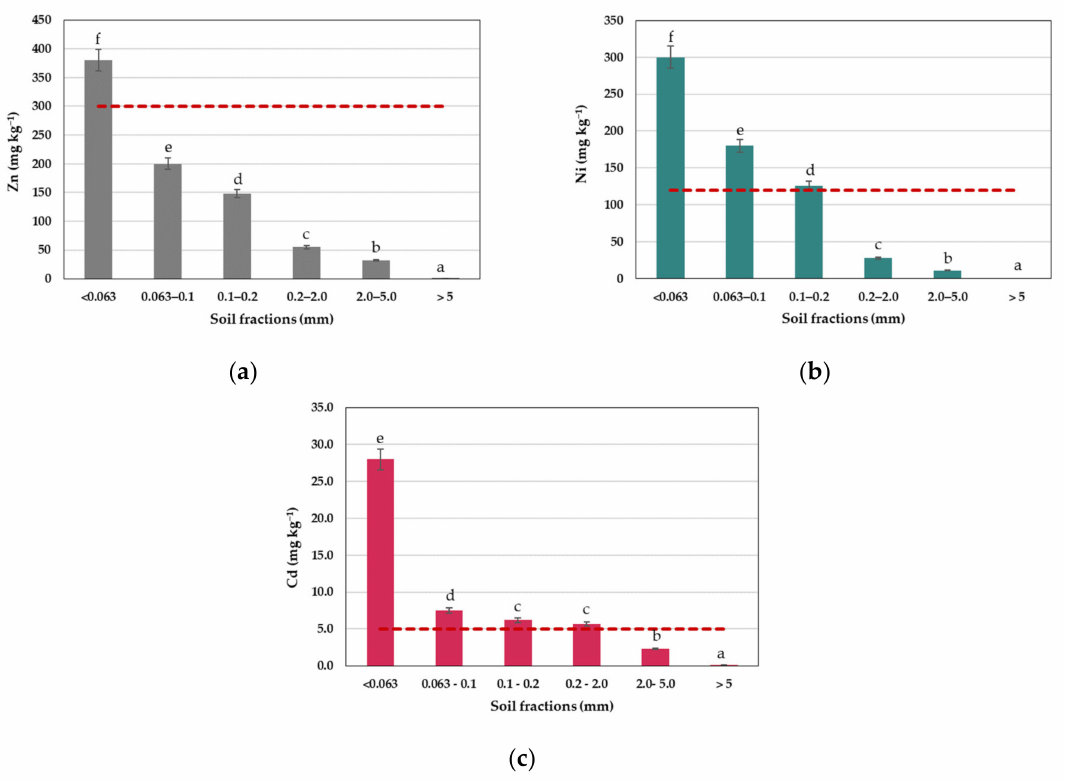
Figure 4. Zn ( a ), Ni ( b ), and Cd ( c ) concentration (mg kg − 1 ) in the different soil size fractions (mm). Values are expressed as the means of the three replicates ( ± SD). Different letters indicate significant differences ( p < 0.05) between metal concentrations in the fractions from soil washing. The red dotted line is the remediation target for each